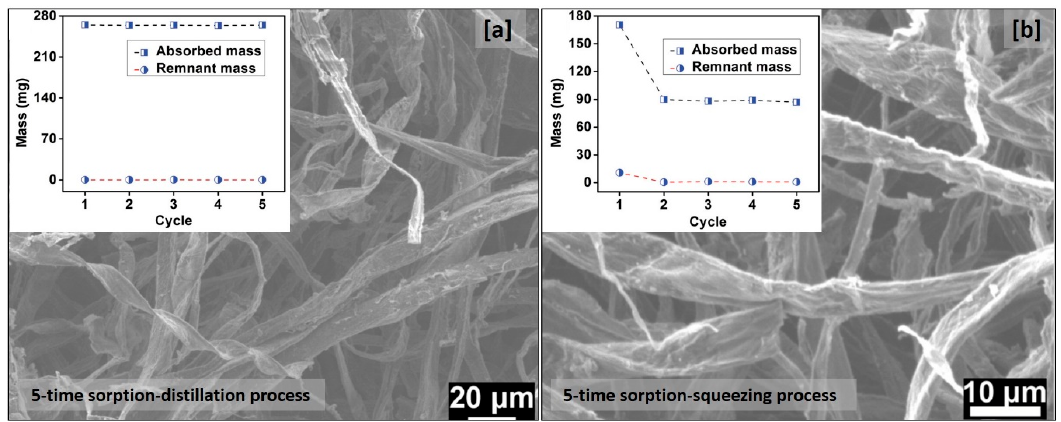
Figure 7. ( a ) Effect of cycles on oil sorption capacity of the CMB aerogel and SEM image after 5 ‐ time sorption/distillation process. ( b ) Effect of cycles on oil sorption capacity of the CMB aerogel and SEM image after 5 ‐ time sorption/squeezing process (modified from [94]).